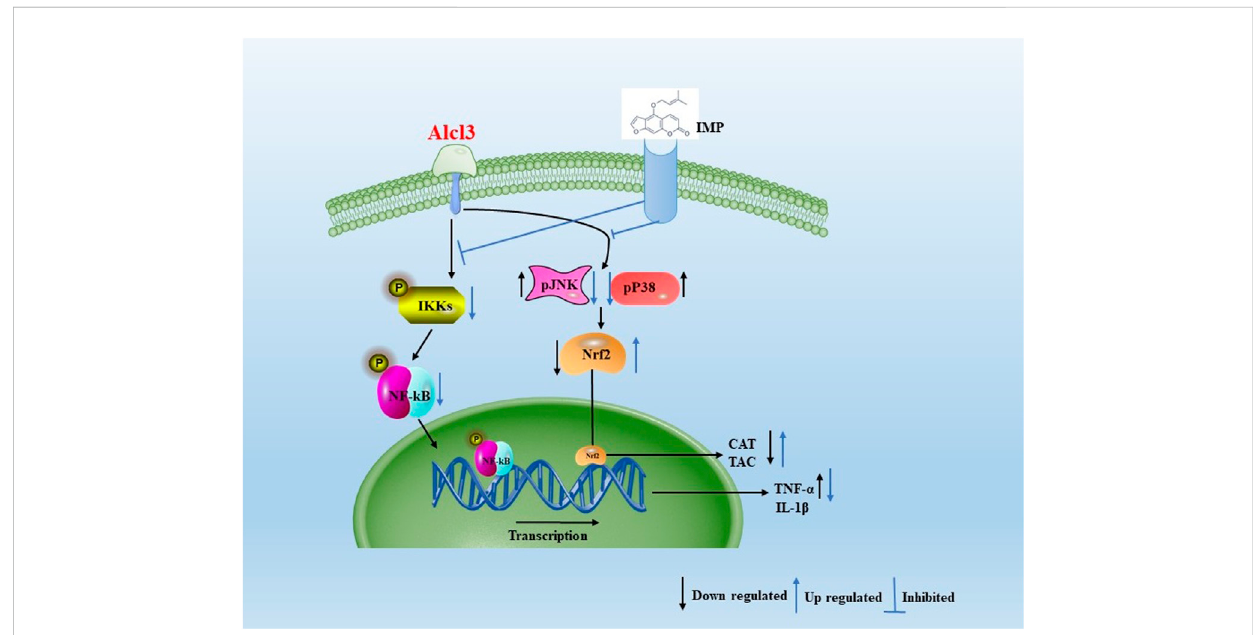
FIGURE 9 Aproposed scheme to summarizing the obtained results. Mechanistic interaction between signaling molecules is shown. In the present study when mice are treated with AlCl3, in fl ammation occurs, which increases expression of in fl ammatory markers such as TNF- α , IL-1 β , and NF-kB. TNF-1 β , NF-kB, and MAPK activation are attenuated by supplementation with IMP. IMP supplementation attenuates Nrf2 and antioxidant enzymes activation during AlCl3